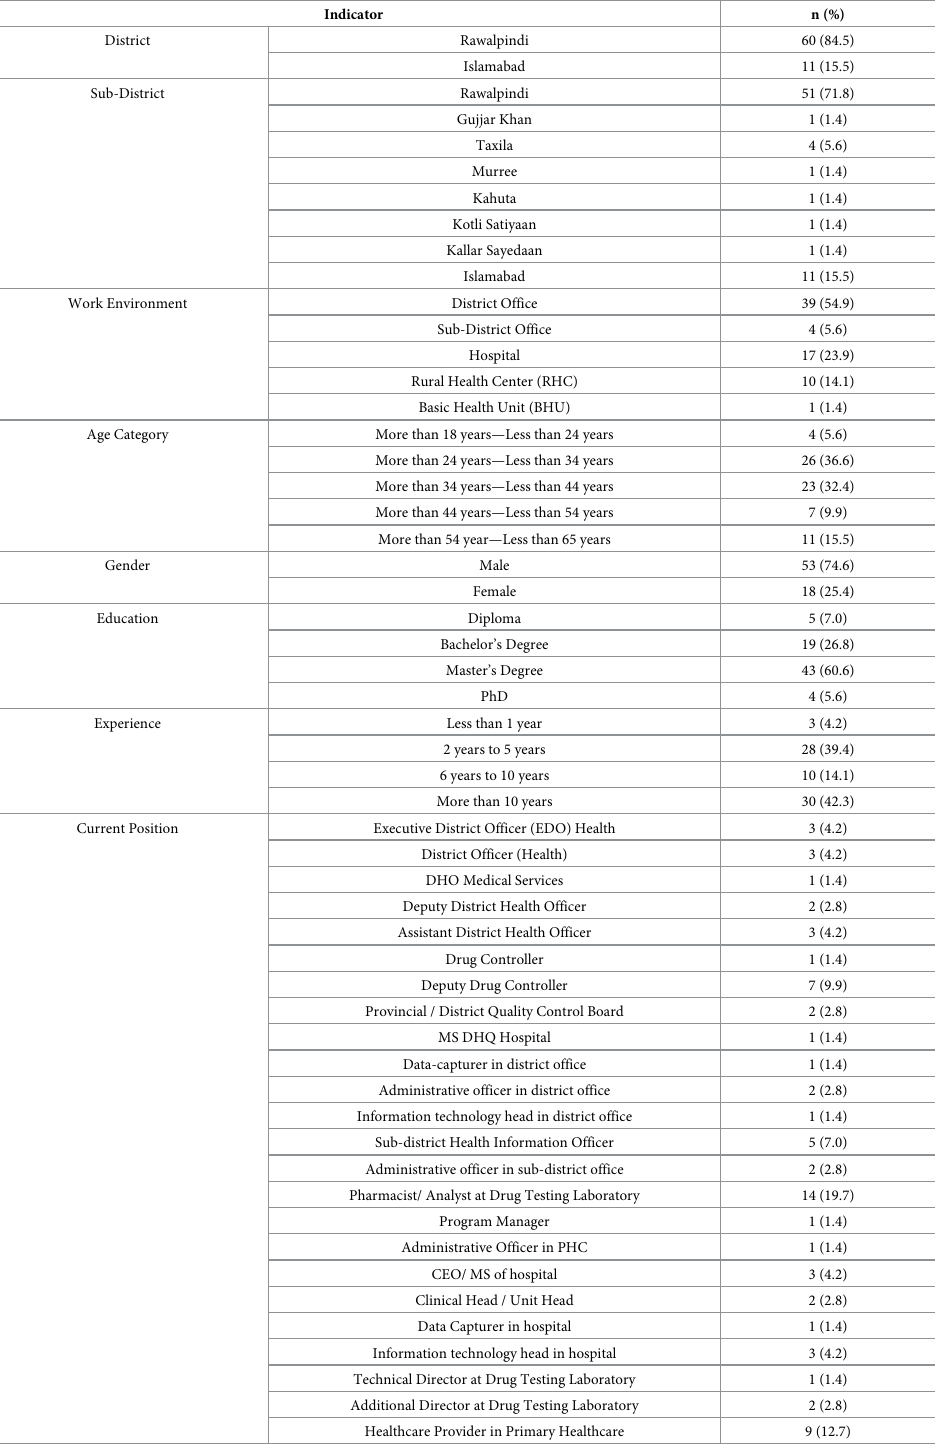
Table 1. Demographic